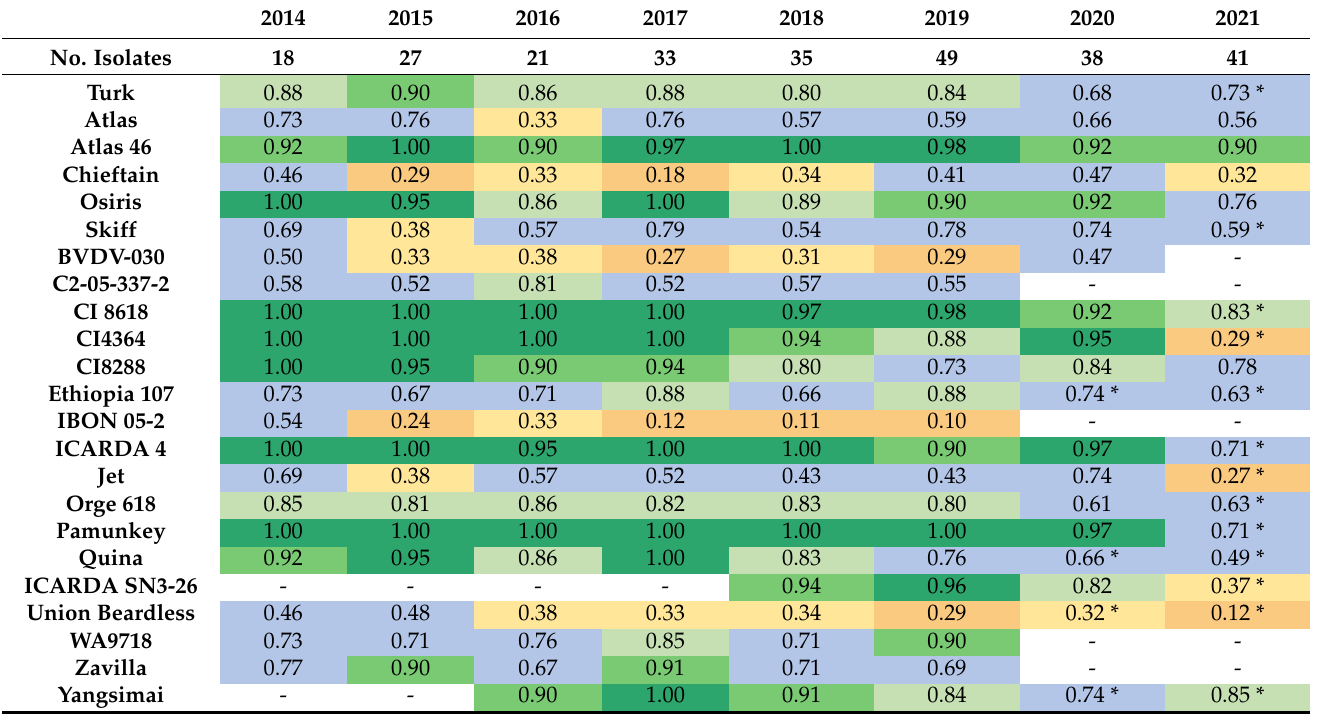
Table 1. Fraction of reactions rated resistant to scald isolates collected from around Australia in the years